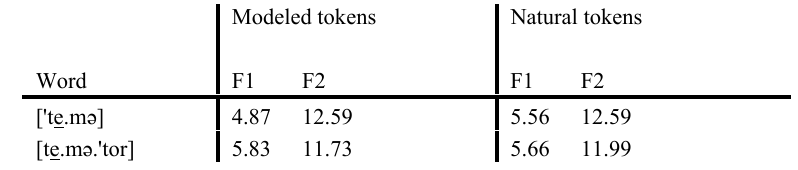
Table 3. F1 and F2 values measured at vowel acoustic mid-point in Bark for modeled and naturally produced derived and underived /e/ words. Values for modeled items are from a single stimulus; values for the naturally produced items are means across nine